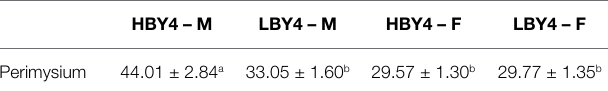
TABLE 4 | Line*Sex 1 interaction for perimysium measurement ( μ m) at d56 (Mean ± SE) 2